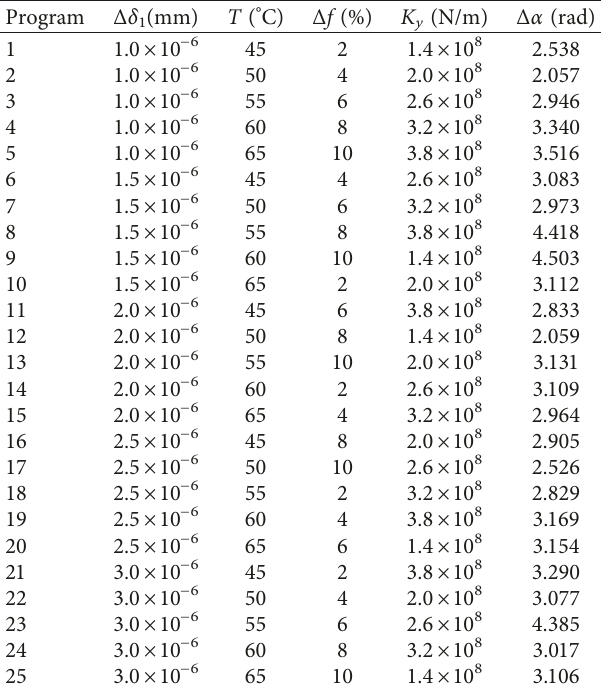
Orthogonal table was selected as the orthogonal experimental design. The results are as follows (Table 2). Table 2: Orthogonal results.